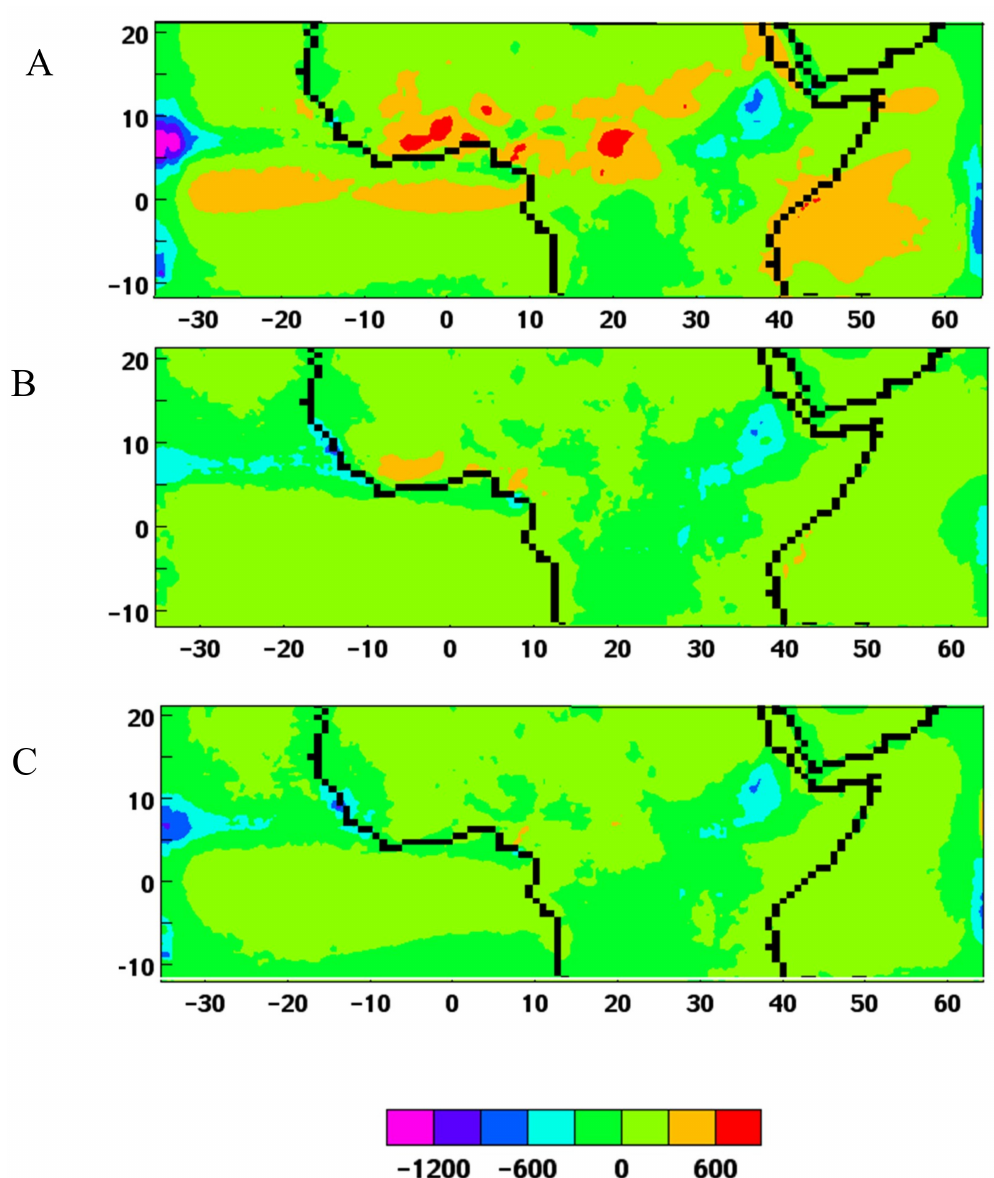
Figure 2. Errors in simulated June–September 1998–2002 precipitation accumulations (mm). ( A ) RM3nc forced by ModelE without bias corrections; ( B ) RM3bc forced by ModelE with bias corrections to LBCs and SST; ( C ) RM3sst forced by ModelE with bias corrections to only